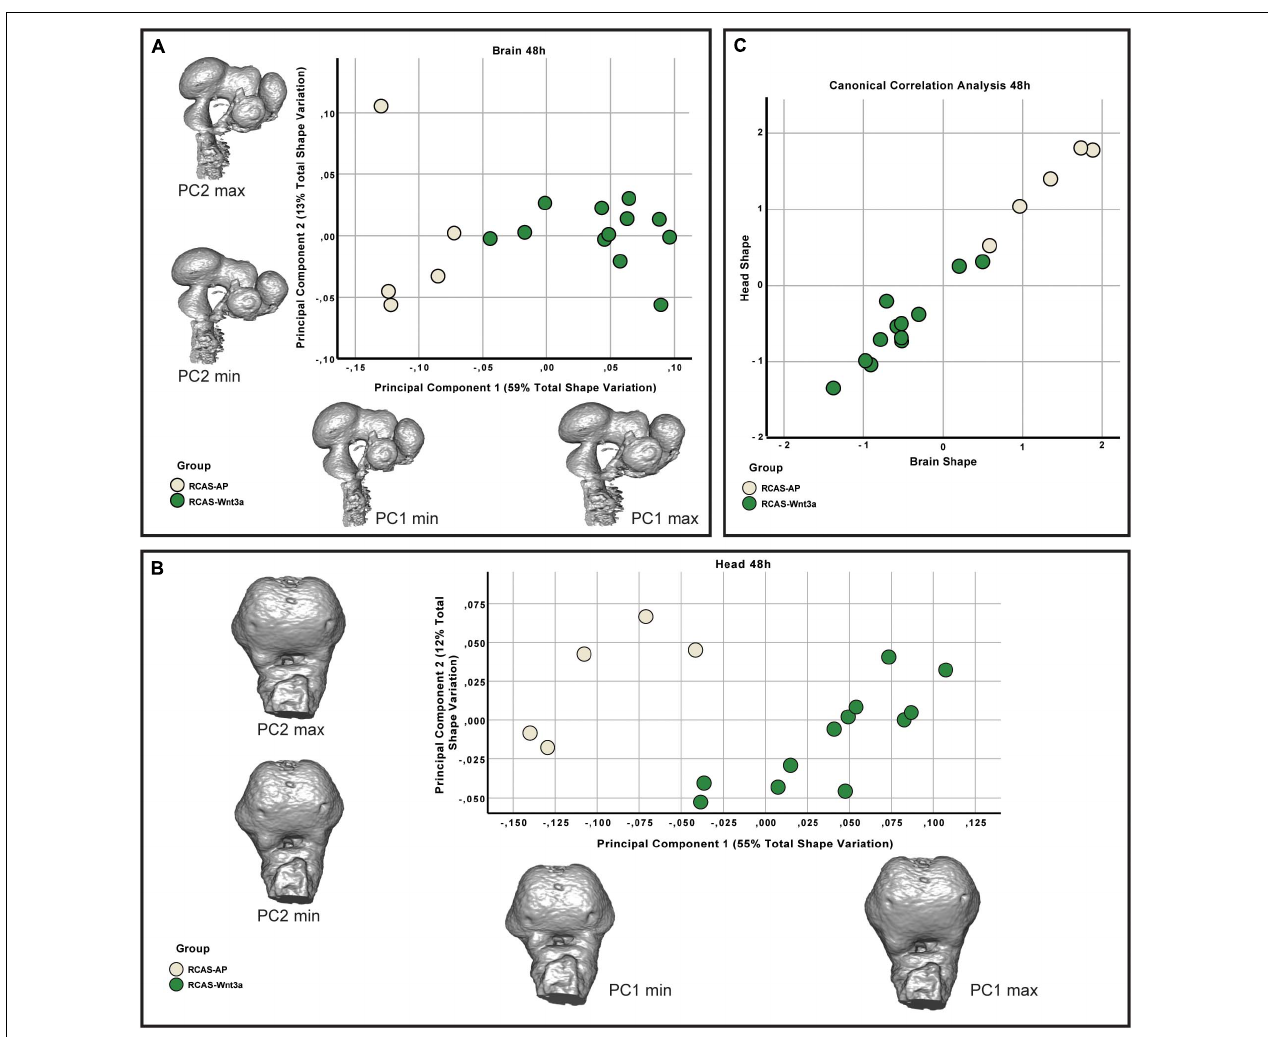
FIGURE 4 | Brain and head shape variation between RCAS-Ap and RCAS- Wnt3a stage HH18. (A) Biplot of the first two principal components of the brain based on 17 landmarks. Gray meshes represent brain shape at the extreme of the principal component. (B) Biplot of the first two principal components of the head based on 21 landmarks. Gray meshes represent head shape at the extreme of the principal component. (C) Canonical correlation analysis of the first five principal components of the head and the first four principal components of the